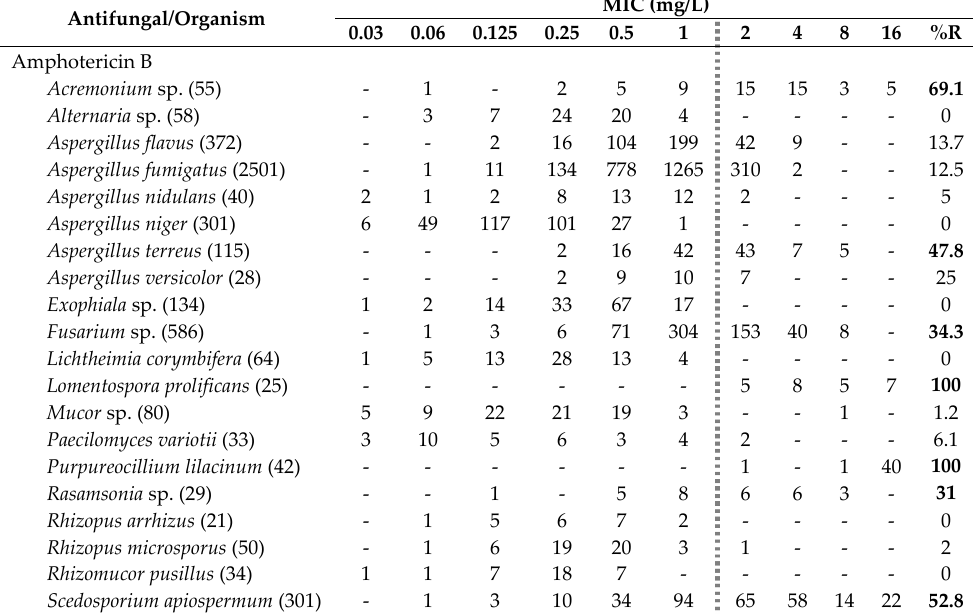
Table 1. Minimum inhibitory concentration (MIC) distributions for amphotericin B and common pathogenic filamentous fungi. The number of isolates included is given in parentheses, together with the number of isolates with each given MIC value. %R denotes the proportion of isolates with non-wild type MICs (i.e., MICs greater than the CLSI 97.5% epidemiological cutoff value (ECV) proposed for A. fumigatus , dashed line [23],) with percentages above 30% in bold face. Dashed Line: no isolates with this MIC.